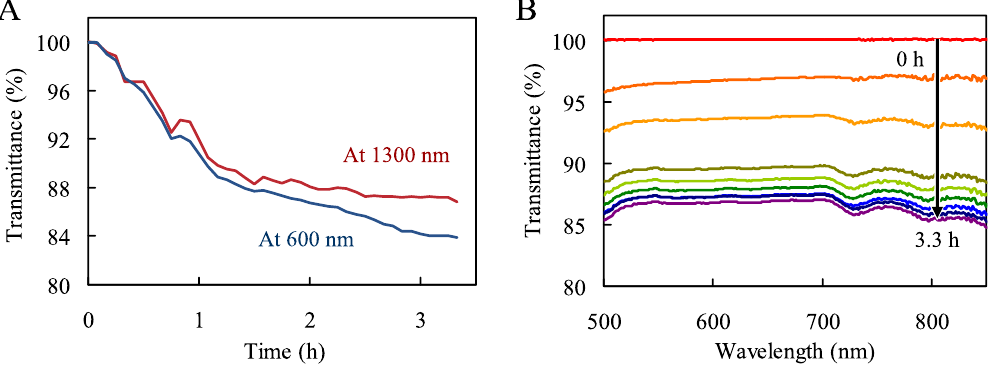
Figure 1. ( A ) Transmittance response monitored by the fiber sensor with 8 cm exposed core length at 600 nm (blue line) and 1300 nm (red line) as a function of time after immersion in a solution containing 1000 mg/L silicate (as SiO 2 ). ( B ) Spectral changes with time from 500 to 850 nm with the fiber sensor under the same conditions. Curves from top to bottom represent increase in time.